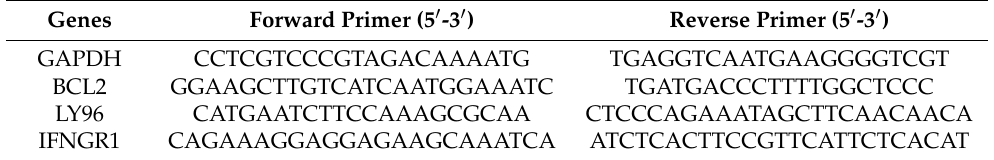
Table 2. The Sequences of